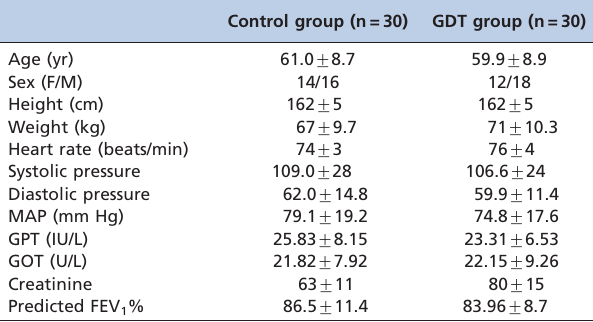
Table 1 - Demographic characteristics and laboratory